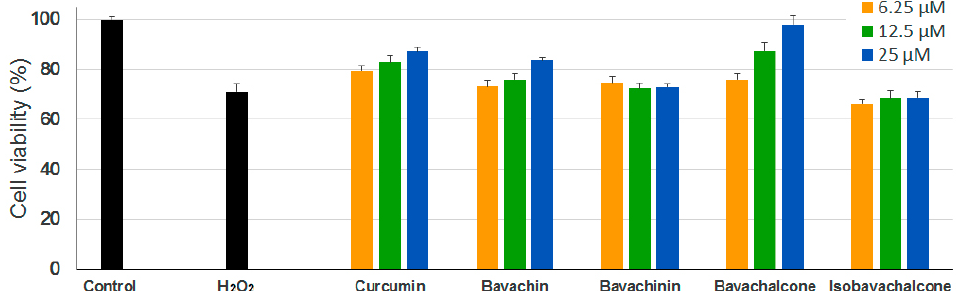
Figure 3. Anti-oxidative effects of PF compounds. PC-12 cells were incubated with different concentrations of PF compounds for 24 h followed by treatment with 450 µM of H 2 O 2 solution for 2 h. Cell viability was measured using MTT assay. Curcumin was used as a positive control. Data are expressed as mean ±